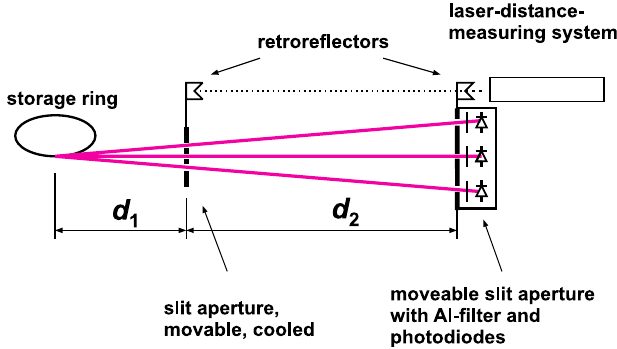
FIG. 17. (Color) Schematic drawing of the setup used to deter- mine the distance to the radiation source point.